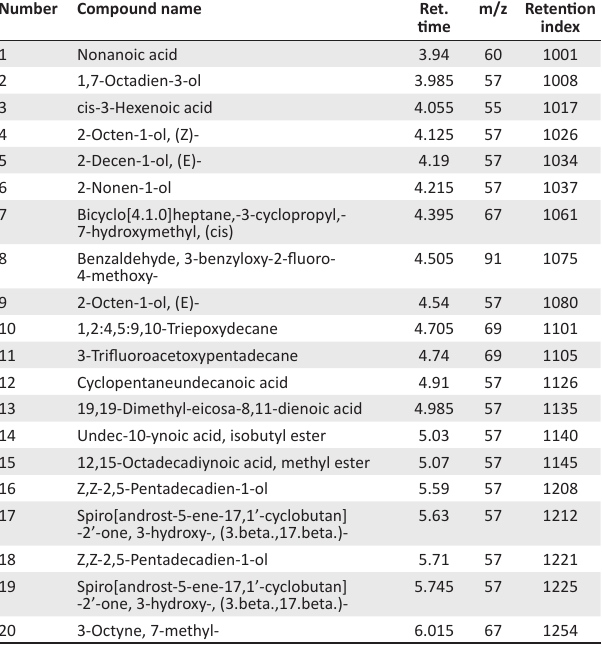
FIGURE 5: Gas chromatography–mass spectrometry spectra of alpha-ylangene as identified with the help of an National Institute of Standards and Technology spectral TABLE 4: Gas chromatography–mass spectrometry profile of Lantana trifolia methanolic extracts identified with the help of National Institute of Standards and Technology gas chromatography–mass spectrometry data base.